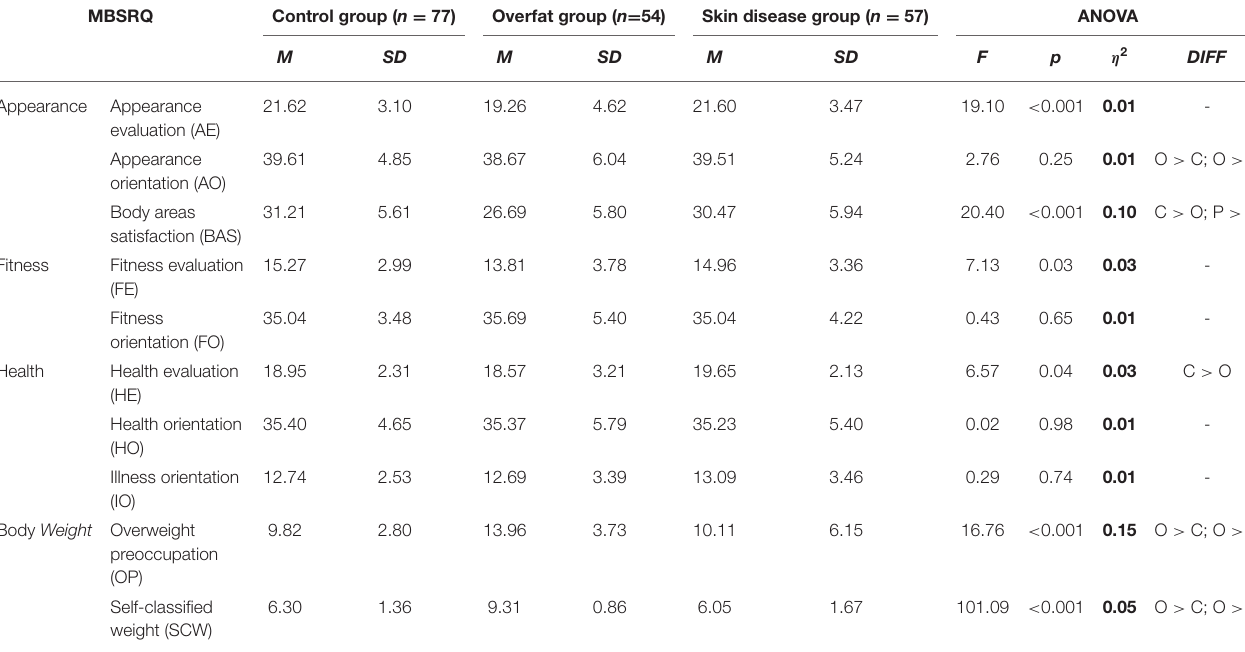
TABLE 2 | Differences in the assessments of one’s body (MBSRQ) between the groups. MBSRQ Control group ( n = 77) Overfat group ( n = 54)